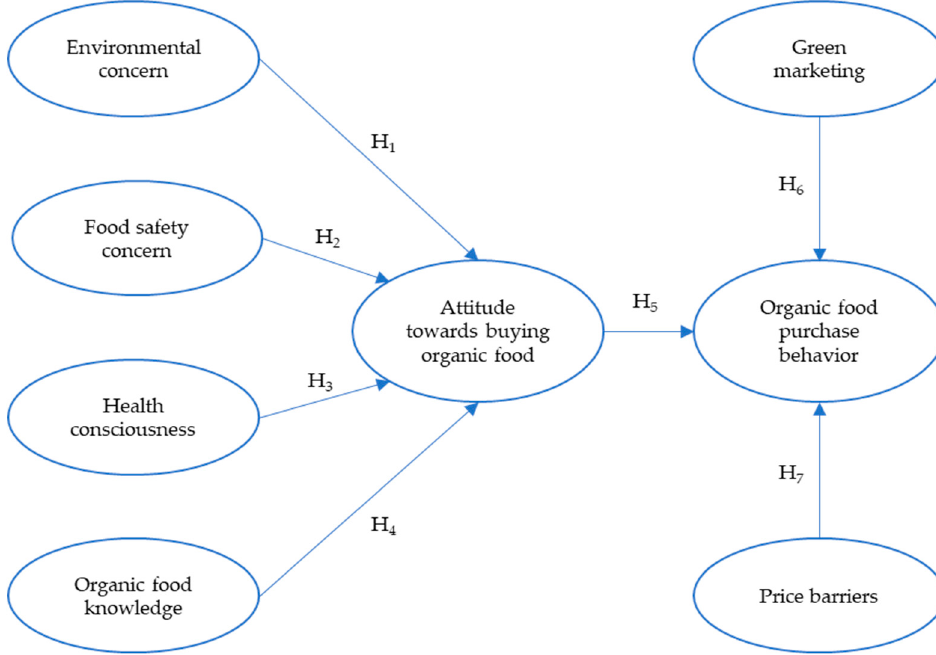
Figure 1. The proposed research model.